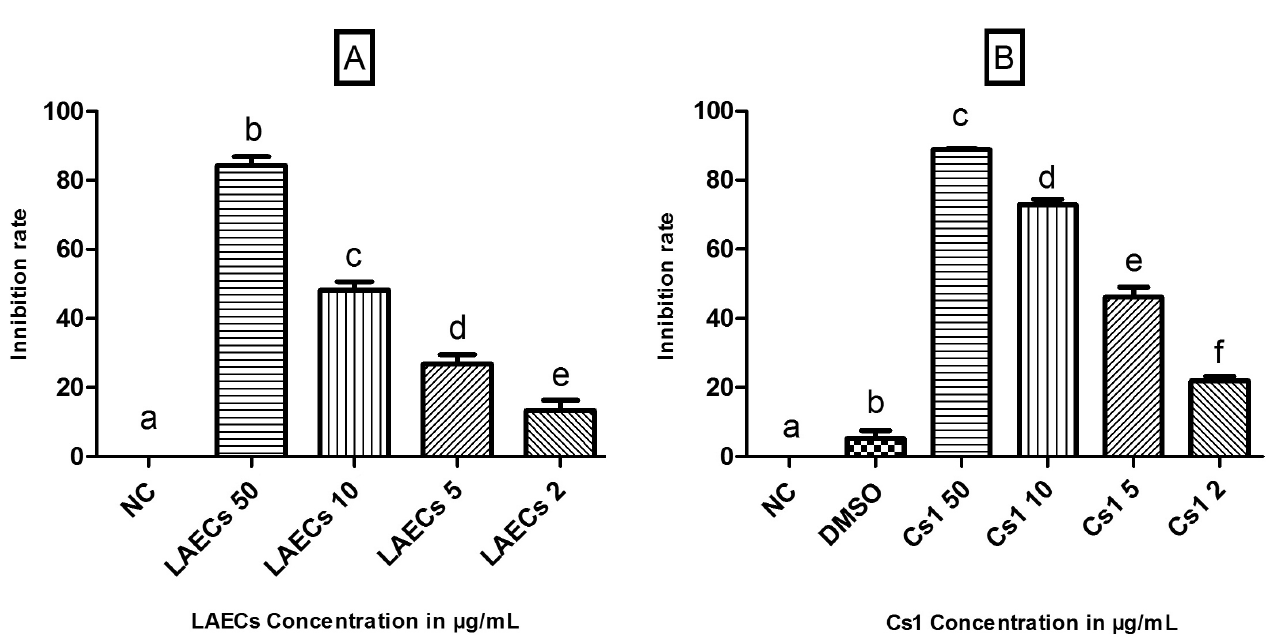
FIGURE 3 - 2,2-diphenyl-1-pricril-hydrazyl (DPPH) radical scavenging activity. (A) lyophilized aqueous extract (LAECs) at 50, 10, 5 and 2 µg/mL; (B) raw ethanol extract (Cs1) at 50, 10, 5 and 2 µg/mL; NC – Negative Control (distilled water); Data are expressed as mean ± SD. Columns with different letters are significantly different (p<0.05).